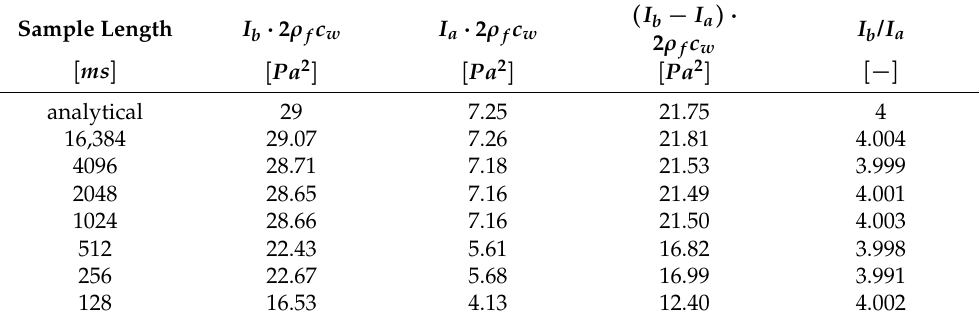
Table 1. Dependance of calculated intensity on sample